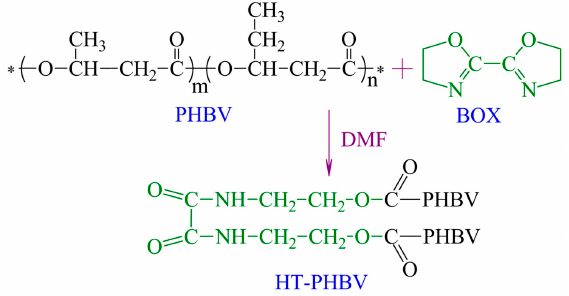
Figure 8. Reaction between PHBHV and BOX. Reprinted with permission from [31]. Copyright © 2008 Elsevier Ltd.